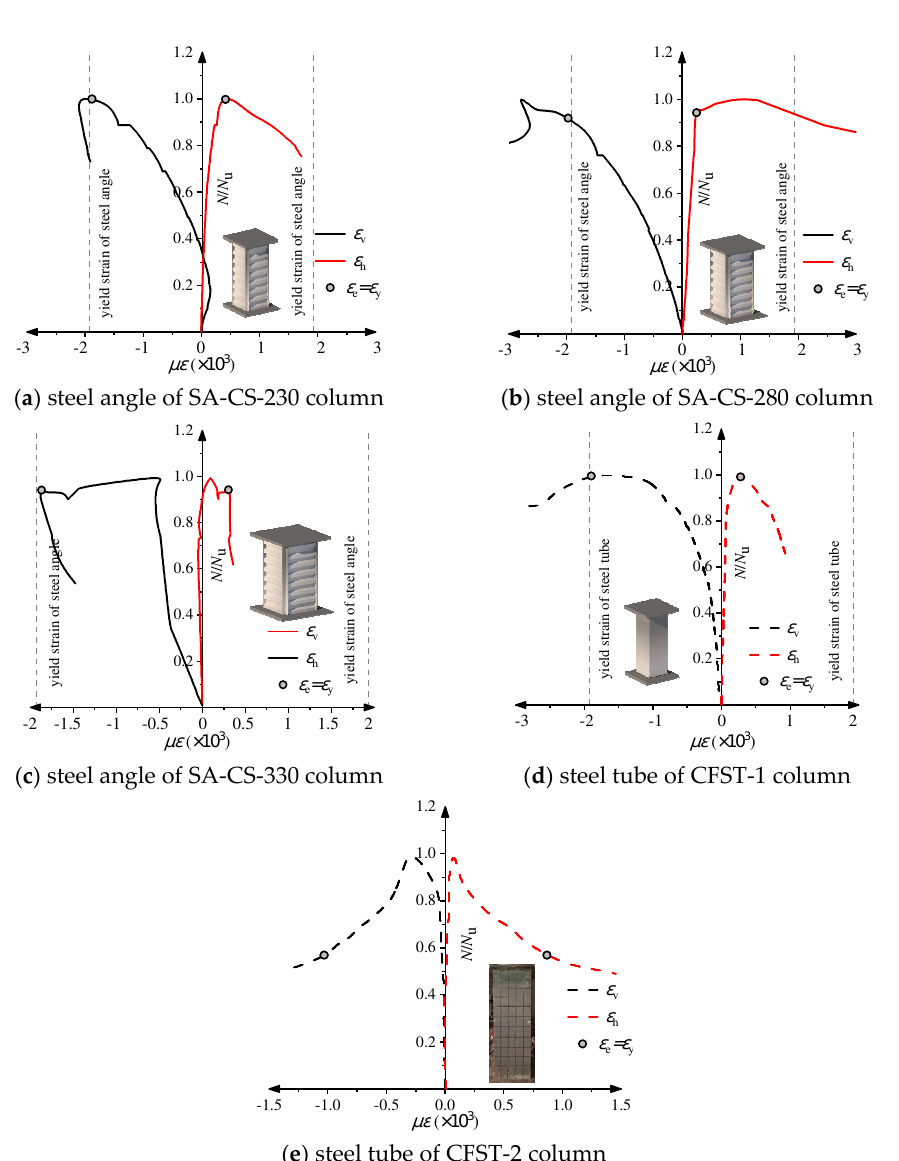
Figure 7. Load–strain curves.